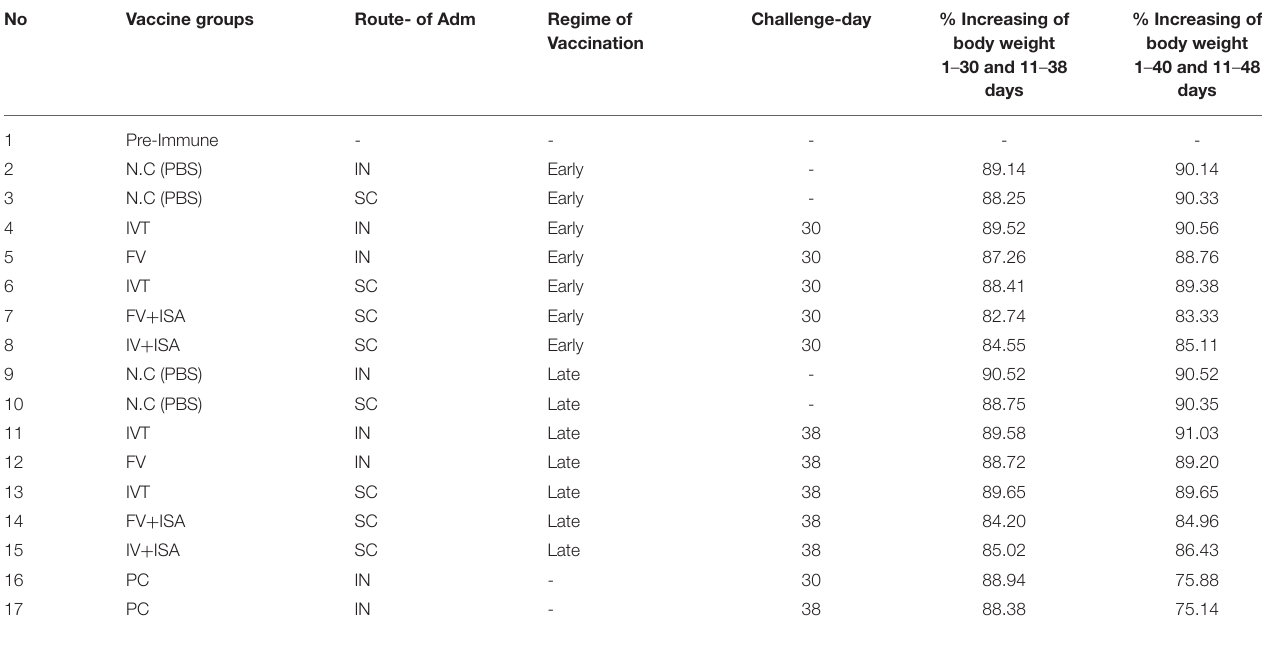
TABLE 3 | The % increasing of body weight in early regime vaccinated groups during 1–30 days and in late regime vaccinated groups during 11–38 days. No Vaccine groups Route- of